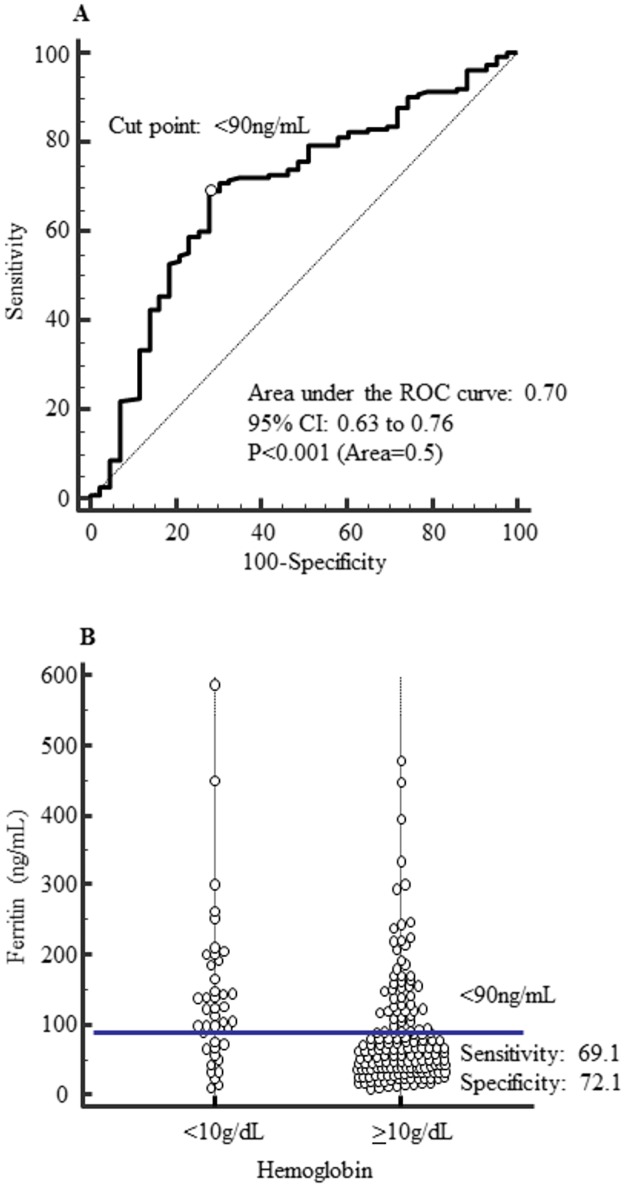
Diagnostic accuracy of serum ferritin.(A) The ROC curve of serum ferritin with Hemoglobin ≥10g/dL. (B) Dot plot of serum ferritin in Hemoglobin <10g/dL and ≥10g/dL. The cutoff point for s-ft was found to be below 90 ng/mL (sensitivity: 69.1%, specificity: 72.1%, p < 0.001).